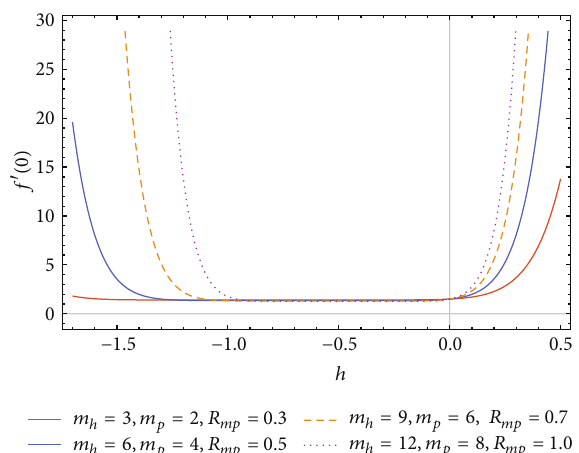
Figure 4: ℎ - curve of tenth-order solution for various 𝑚 ℎ , 𝑚 𝑝 , and 𝑅 𝑚𝑝 .